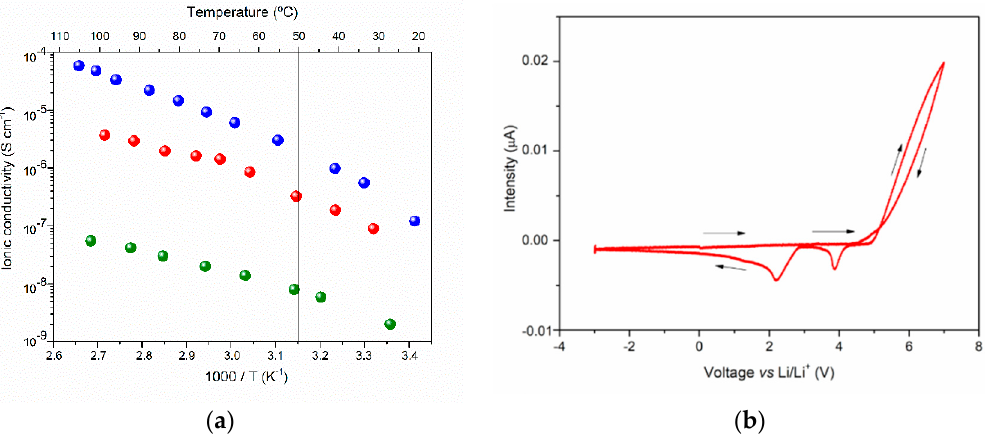
Figure 4. ( a ) Arrhenius conductivity plots of d-PCL(530)/siloxane [34] (black symbols), d-PCL(530)/ siloxane 5.2 -LiTrif-ErTrif 3 [21] (blue symbols), and d-PCL(530)/siloxane 9.1 LiTrif-[Er(tta) 3 (H 2 O) 2 ] (red symbols); ( b ) voltammogram of d-PCL(530)/siloxane 9.1 LiTrif-[Er(tta) 3 (H 2 O) 2 ] (scan rate = 100 m Vs − 1 ).